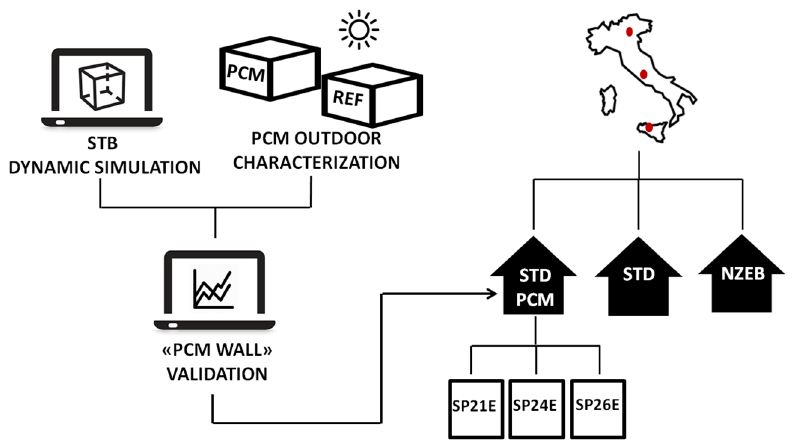
Figure 1. Schematic of methodology used for the study proposed. Red spots show the location of the three cities in which the buildings were tested.